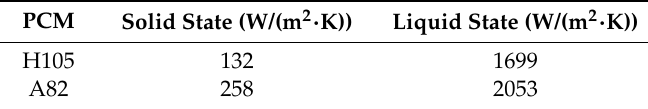
Table 4. Heat Transfer Coefficients for H105 and A82